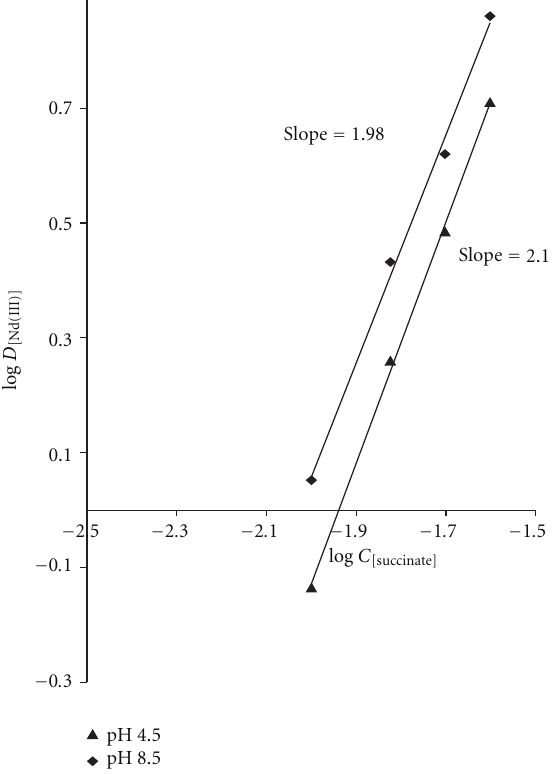
Figure 3: Log-log plot of log D [Nd(III)] versus log C [Succinate] at 0.1 M N- n -octylaniline with pH 4.5 and pH